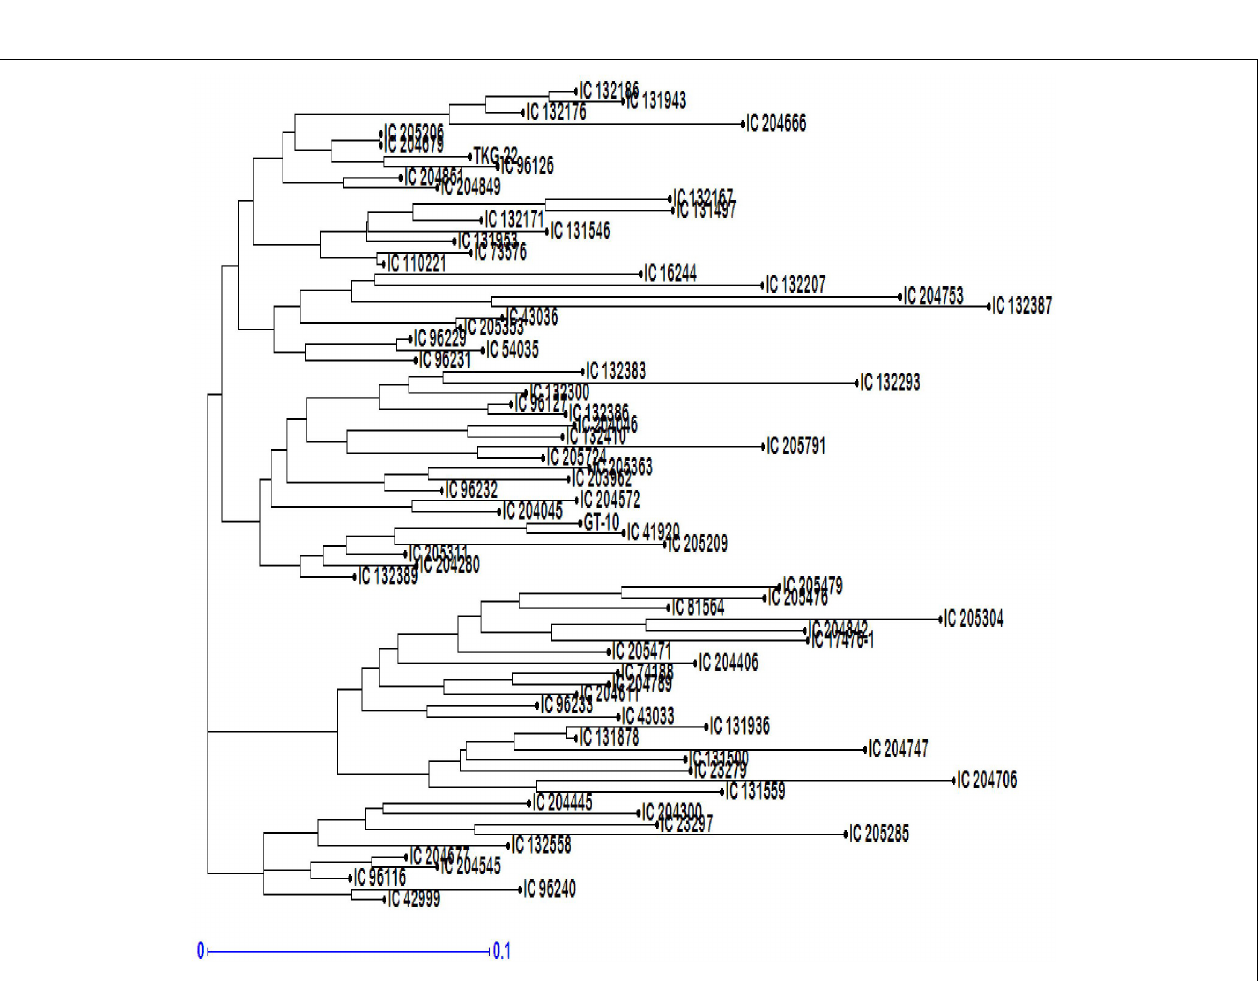
FIGURE 10 | Neighbor-joining (NJ) tree-based dendrogram depicting genetic diversity among 76 genotypes of sesame.